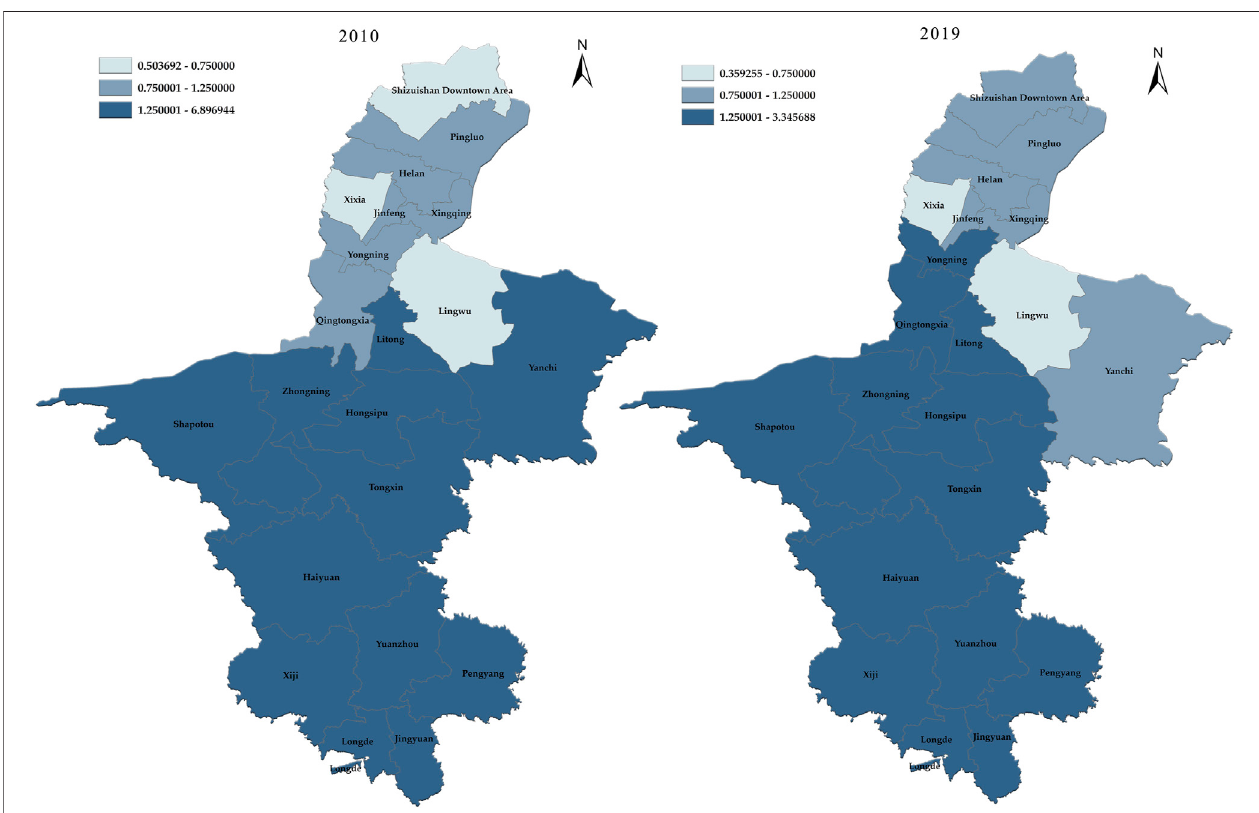
FIGURE 7 | The inconsistency index of Ningxia in 2010 and